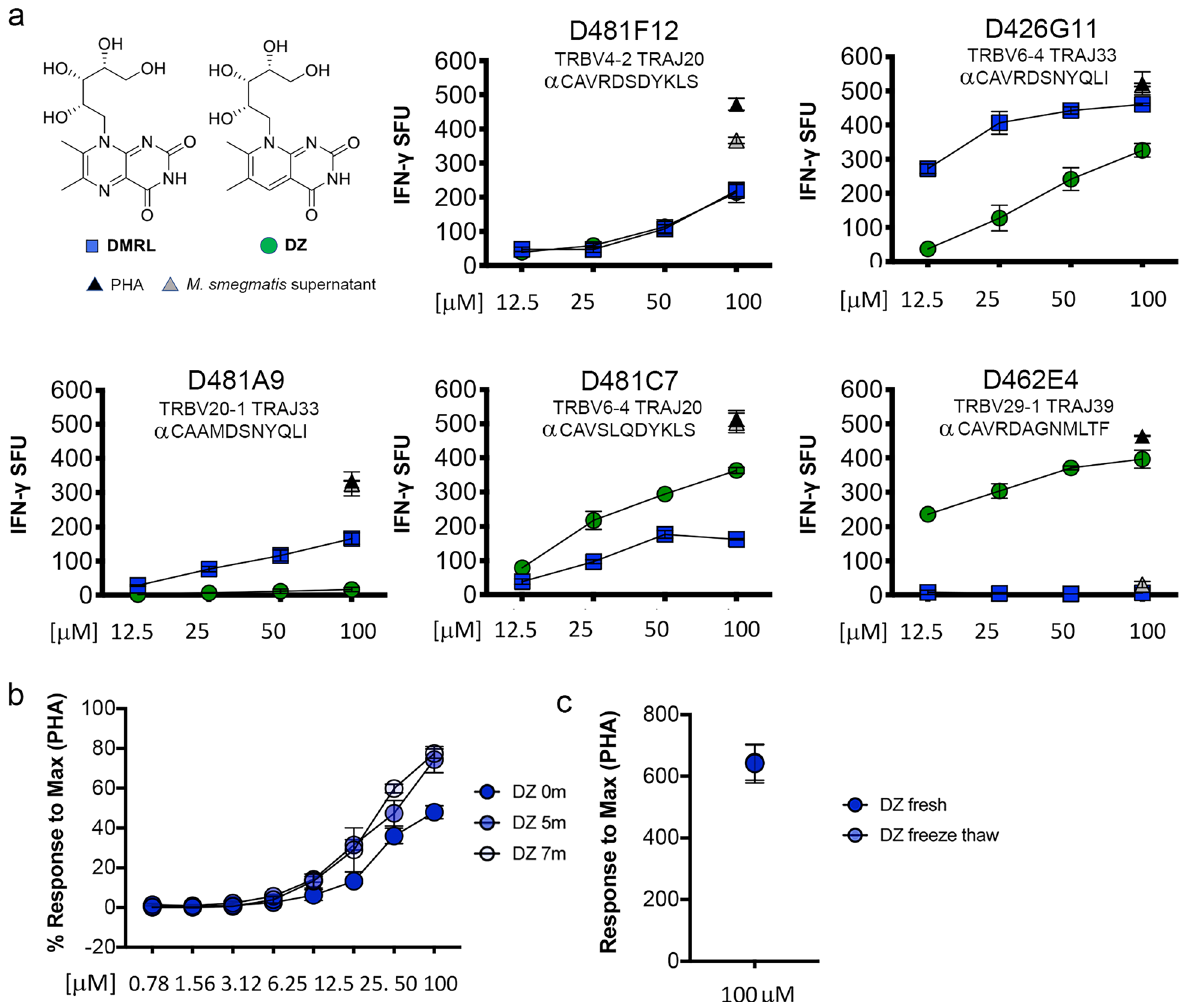
Figure 3. MR1T cell responses to DZ. ( a ) The IFN-γ response by 1 × 10 4 MR1T cell clones was measured in an ELISPOT assay with 1 × 10 4 DC pulsed with the indicated concentrations of DMRL or DZ. P values were determined by simple linear regression of the slope and elevation of for DZ and DMRL. ( b ) The same synthesis of DZ was tested as described in ( a ) following storage of the compound in dimethylsulfoxide (DMSO) at − 80 °C for 5 and 7 months, using D481 C7 response as the readout. ( c ) A single vial of DZ stored in DMSO at − 80 °C was tested initially after thawing or following a cycle of refreezing and thawing prior to use in an ELISPOT assay, using D481 C7 response as the readout. Phytohemagglutinin (PHA) and supernatant from M. smegmatis , as described in the “Experimental procedures”, were used as positive controls for all assays. Error bars indicate the standard deviation of technical replicates. Data shown are representative of 3 independent